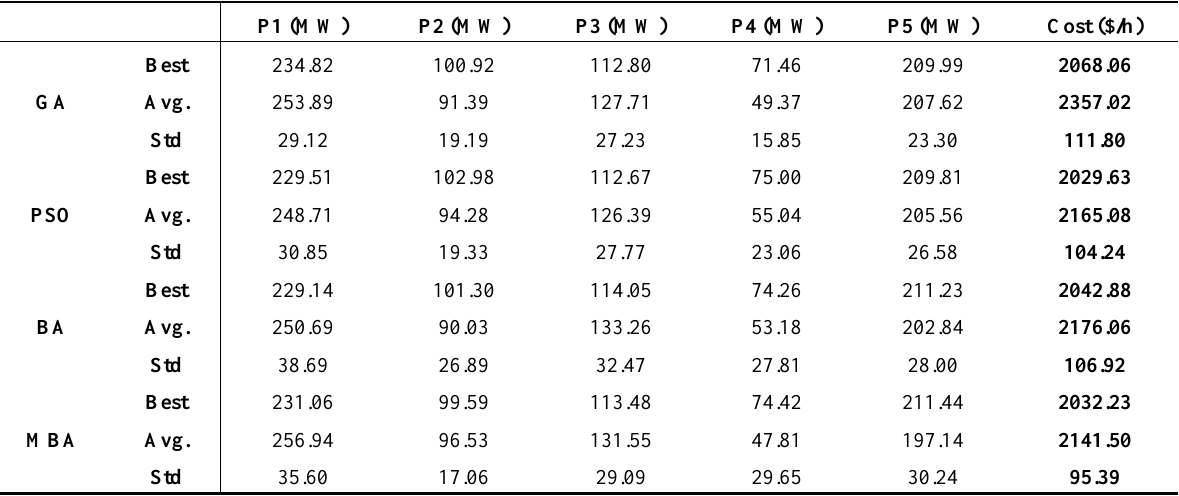
Table 8. Economic dispatch